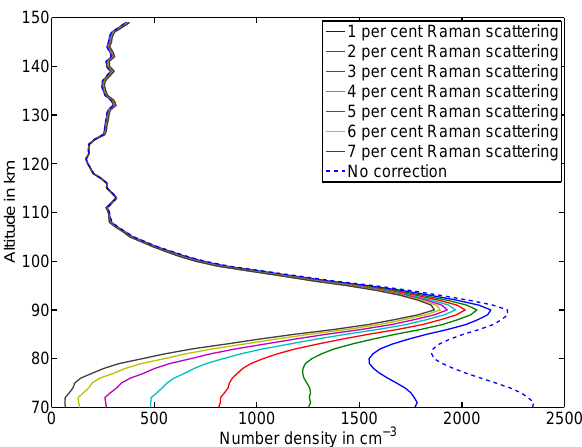
Fig. 31. Plot of Mg + (279.6nm) average profile of all single day results of the 2-D retrieval in the equatorial region (15 ◦ S to 15 ◦ N) for different percentages of Raman scattering in the Ring effect correction. For altitudes above 80km the Ring effect correction is negligible and it is very small above 70km. In the peak region the emission dominates the background signal. Because of this the peak value rises with higher Raman scattering percentage (as discussed in Sect.